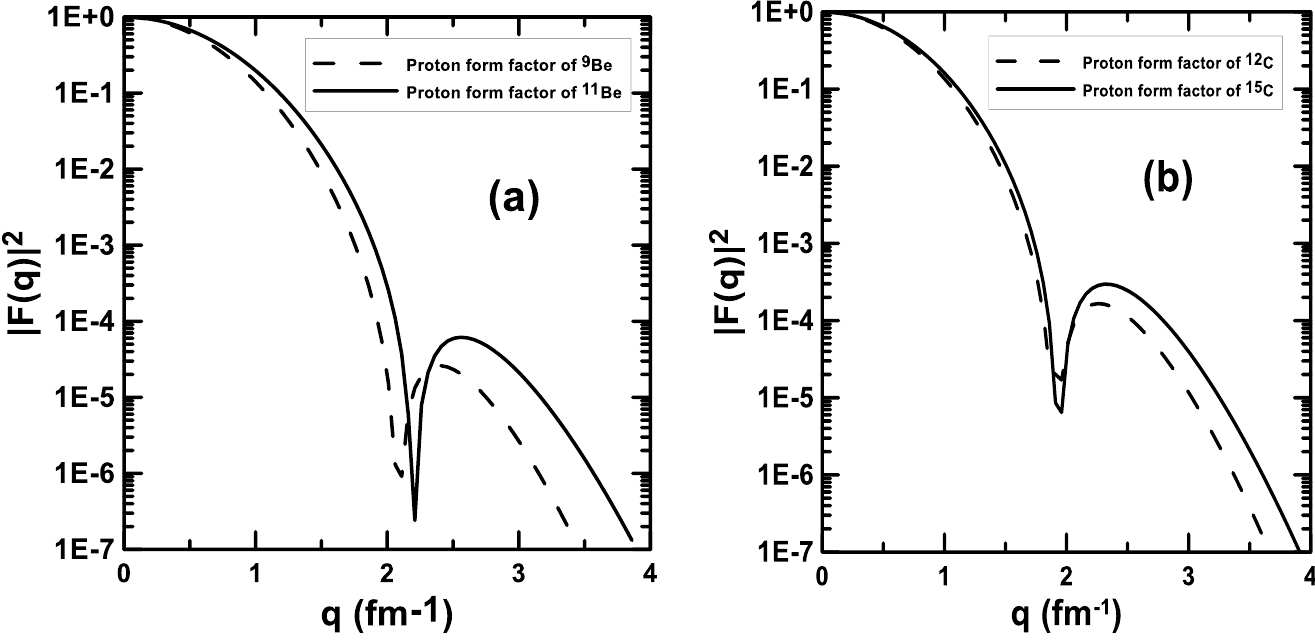
Fig.5: The comparison between the calculated proton form factors of unstable (exotic) nuclei